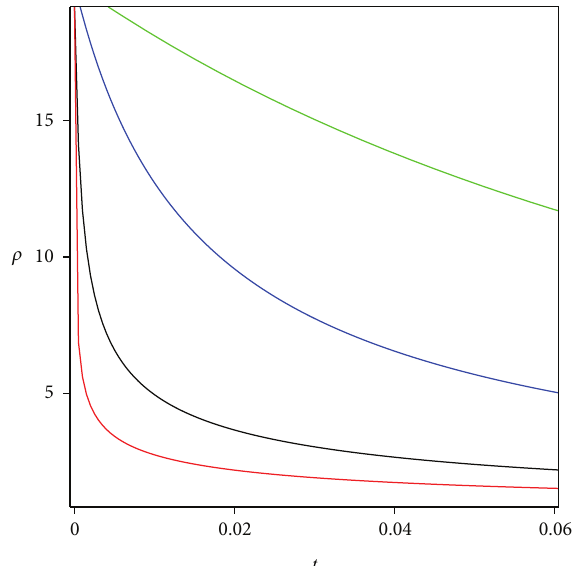
Figure 6: Scale factor versus time for 𝐵 = 3 , 𝛼 = 0.9 , and 𝐴 = 1/3 . 𝑛 = 1 (green line), 𝑛 = 2 (blue line), 𝑛 = 3 (black line), 𝑛 = 4 (red line). (a) General behavior. (b) Early universe.